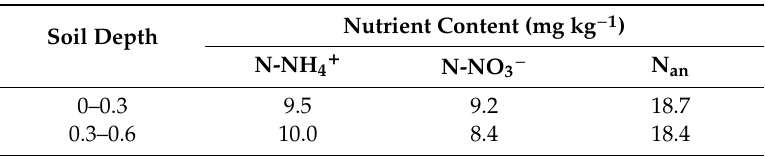
Table 2. The nitrogen ‐ related soil characteristics before spring 2018 planting of sunflower in the experimental locality (Dolná Malanta, Nitra, Slovak Republic).